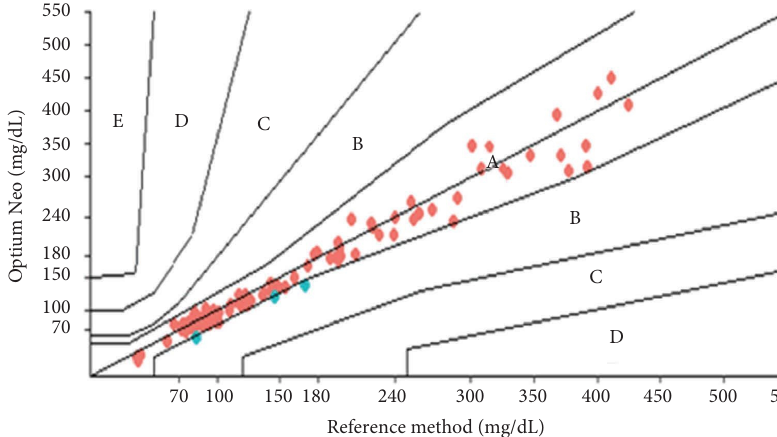
Figure 7: Error grid for the FreeStyle Optium Neo ® glucometer.